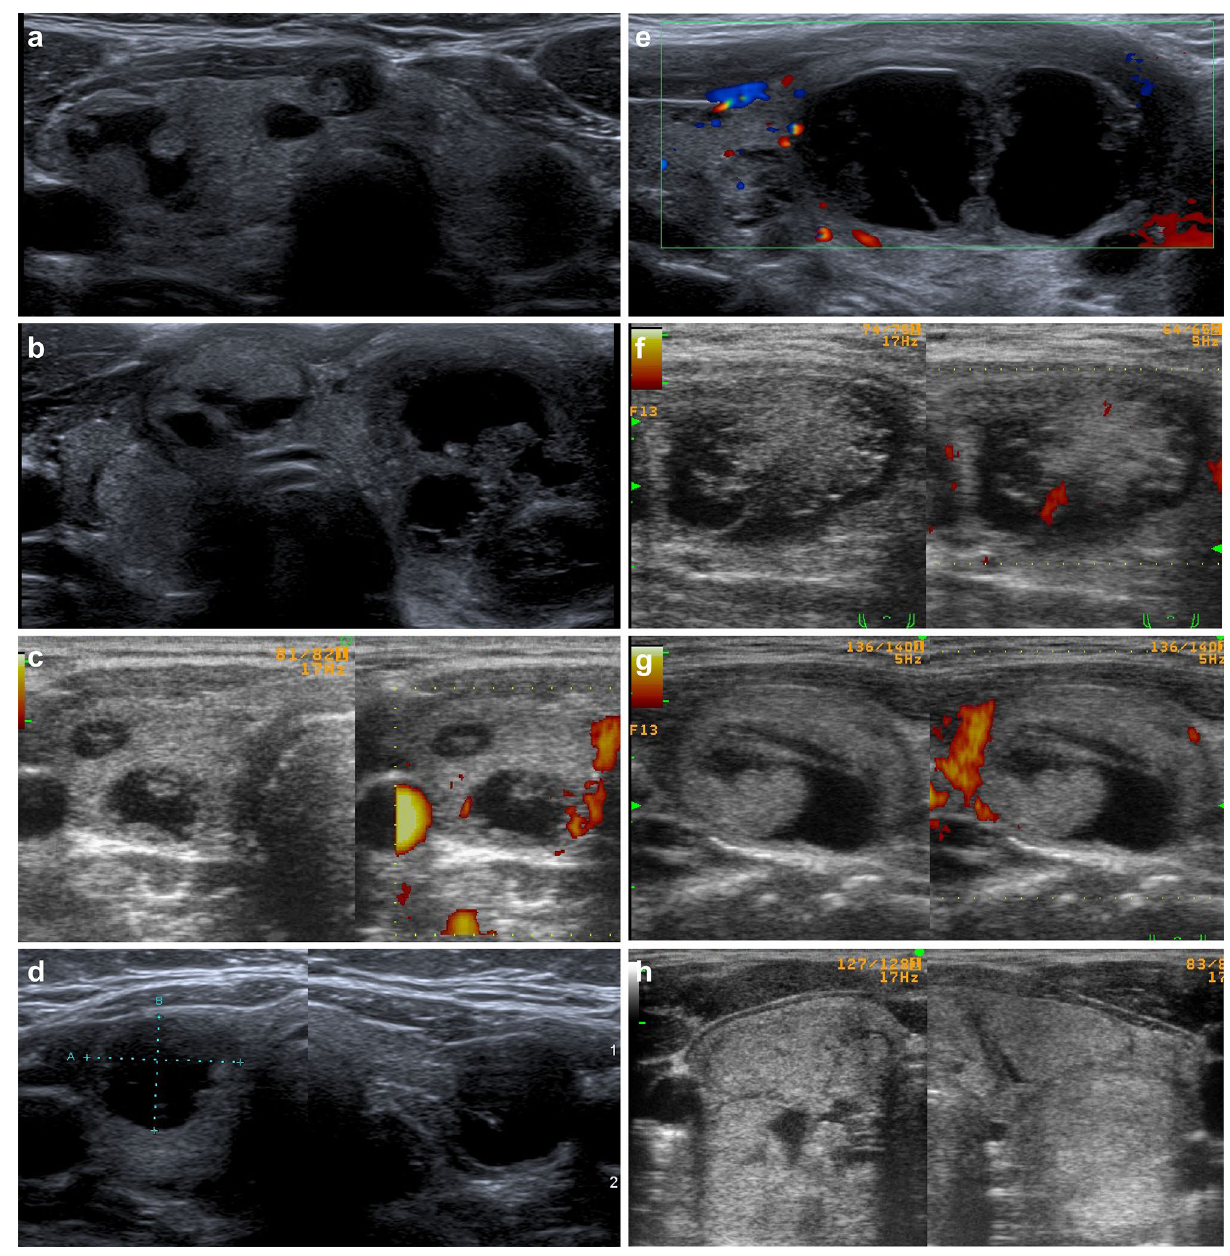
Figure 1. (a-h) Ultrasonographic presentation of MNG in all DICER1 mut+ pediatric patients. ( a–c ) A classic image of MNG for DICER1 syndrome—multiple focal lesions within thyroid (“polymorphic mix”) with dominating mixed cystic and solid nodules (type II) and single cystic (type I) or solid (type II) lesions; ( d ) type I (simple cysts); ( e ) type Is (septated cyst); ( f,g ) type II (mixed cystic and solid); ( h ) type III